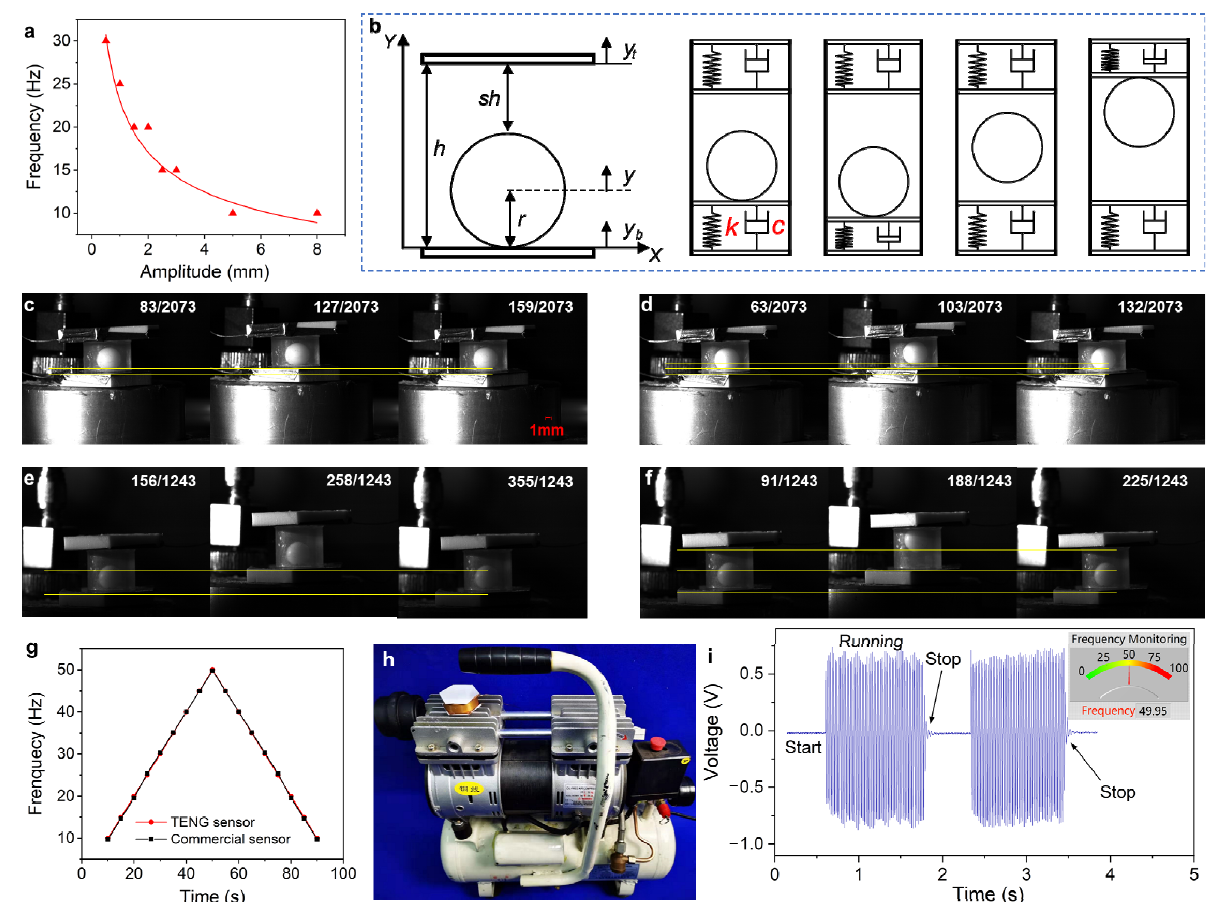
Figure 4. Working range and working characteristics of the BB-TENG sensor. ( a ) The minimum stable frequency at different amplitude. ( b ) Equivalent dynamic model of the PTFE ball bouncing in the container cylinder. PTFE ball-bouncing status at ( c ) frequency of 25 Hz, ( d ) frequency of 30 Hz and amplitude of 0.5 mm with a ball diameter of 5 mm and container cylinder height of 6 mm. PTFE ball-bouncing status at ( e ) frequency of 10 Hz, ( f ) frequency of 15 Hz, and amplitude of 3 mm with a ball diameter of 5 mm and container cylinder height of 8 mm. ( g ) Comparison between the BB-TENG sensor and a commercial vibration sensor. ( h ) The BB-TENG sensor is arranged on the air compressor and ( i ) used to monitoring the vibration condition of the air compressor.